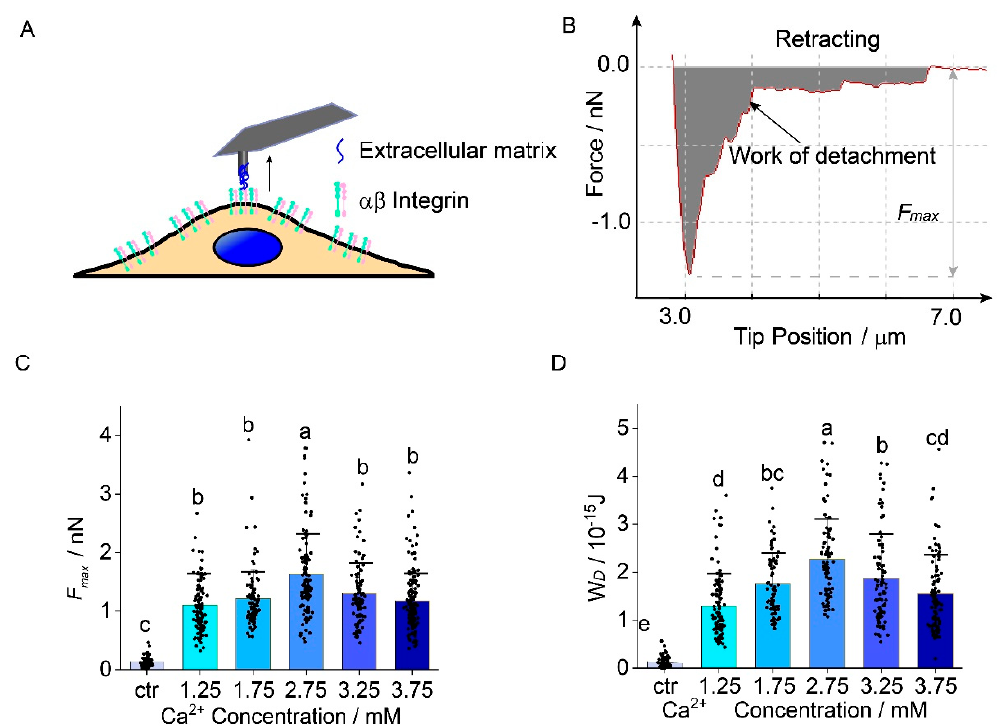
Figure 2. The effects of extracellular Ca 2+ concentration on adhesion between human chondrocytes and extracellular matrix. ( A ) Schematic of the measurement for the adhesion between chondrocytes and extracellular matrix on AFM tip; ( B ) Example of a retraction force-distance curve obtained by cell to extracellular matrix adhesion measurement. F max is the difference between the peak force value and the baseline of complete detachment. Work of detachment (The gray region) represents the energy during the detachment process; ( C ) As Ca 2+ concentration increases, forces between chondrocytes and extracellular matrix increase by 48.0% and reach the peak at 2.75 mM Ca 2+ concentration then decrease by 26% Ca 2+ concentration from 2.75 mM to 3.75 mM; ( D ) The energy during the detachment process increases by 72% from Ca 2+ concentration 1.75 mM to 2.75 mM, decreases by 31.3% from Ca 2+ concentration 2.75 mM to 3.75 mM. 90 cells for each group are measured and analyzed. ANOVA and Tukey’s post hoc is performed for data analysis. Letters (a, b, c, and d) above the bars correspond to distributions that are (letters different) or are not significantly different (letter shared) at the p < 0.05 level.